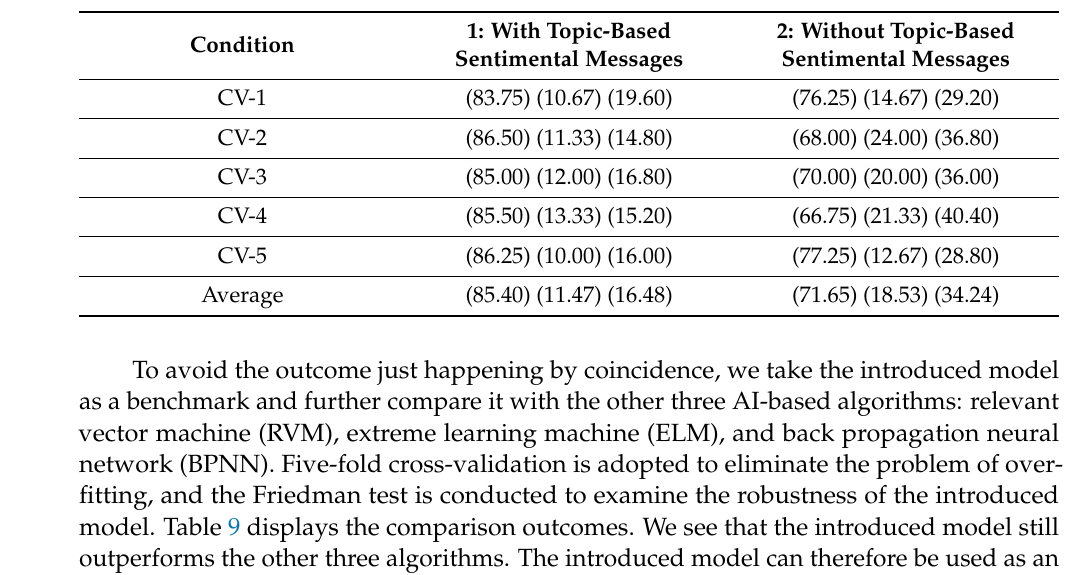
Table 8. The outcomes of comparison (Accuracy) (Type I error) (Type II error).